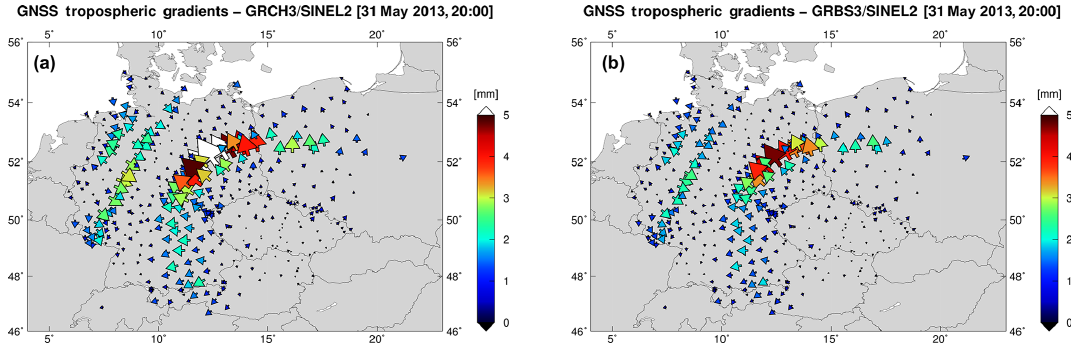
Figure 6. Tropospheric gradient maps on 31 May 2013 (18:00UTC) from GNSS solutions using the SINEL2 observation weighting scheme: Chen and Herring mfg (a) ; Bar-Sever mfg (b) .